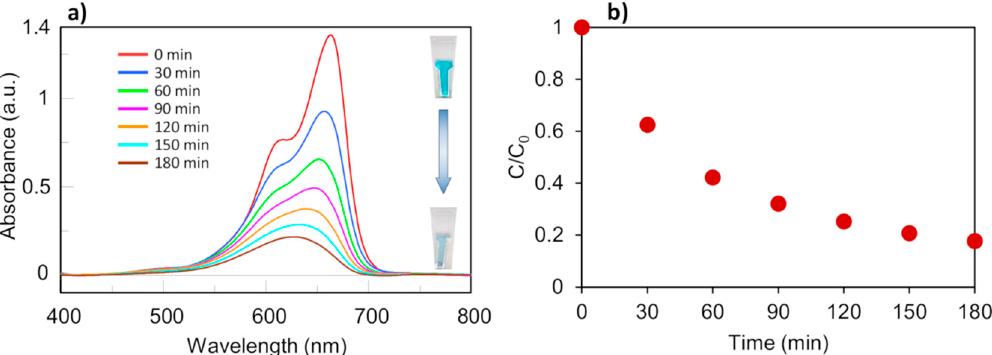
Figure 3. ( a ) UV–visible absorbance spectra indicating the photocatalytic degradation of MB dye using HDPE-TiO 2 under UV-B irradiation and ( b ) plot of C/C 0 versus time under UV-B irradiation.